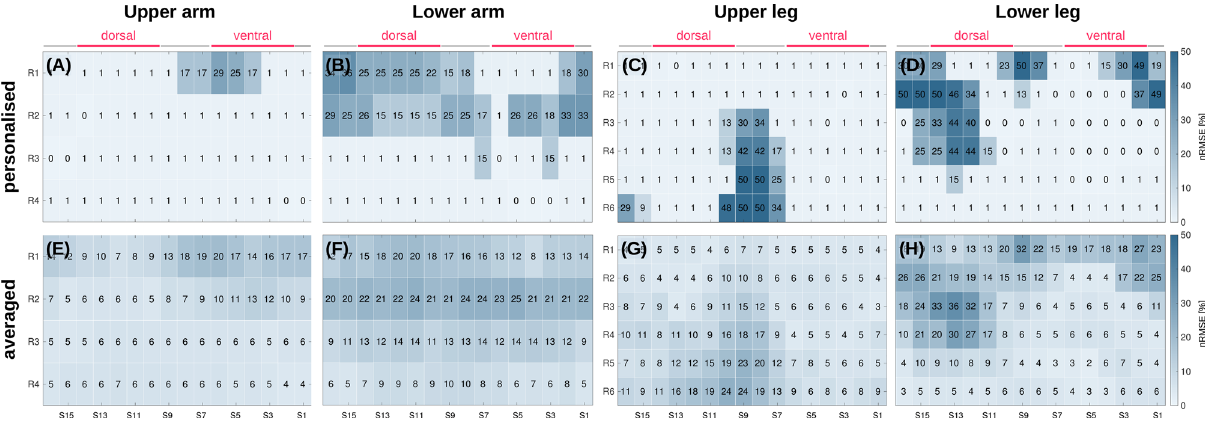
Figure 4. Comparison of athlete personalised (here ID10, right body side) and population averaged (ID1, ..., ID10) marker errors for stride duration, while running at 4 m/s. ( A,E ) nRMSE maps for upper arm. ( B , F ) nRMSE maps for lower arm. ( C , G ) nRMSE maps for upper leg. ( D , H ) nRMSE maps for lower leg.